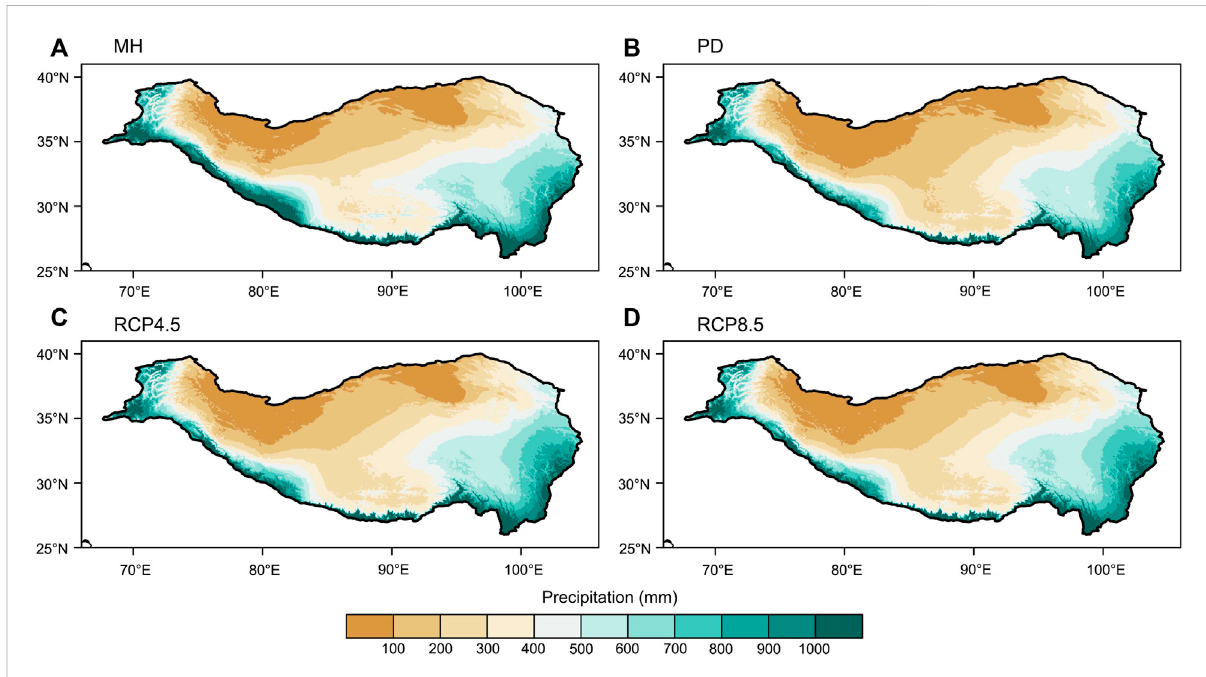
FIGURE 4 Distribution of average annual precipitation (units: mm) across TP. (A) MH, (B) PD, (C) RCP4.5, (D)